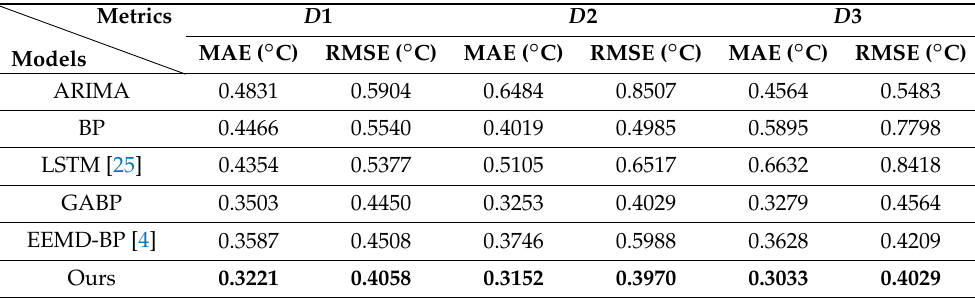
Table 1. The absolute average error (MAE) and the root mean square error (RMSE) among various methods and various